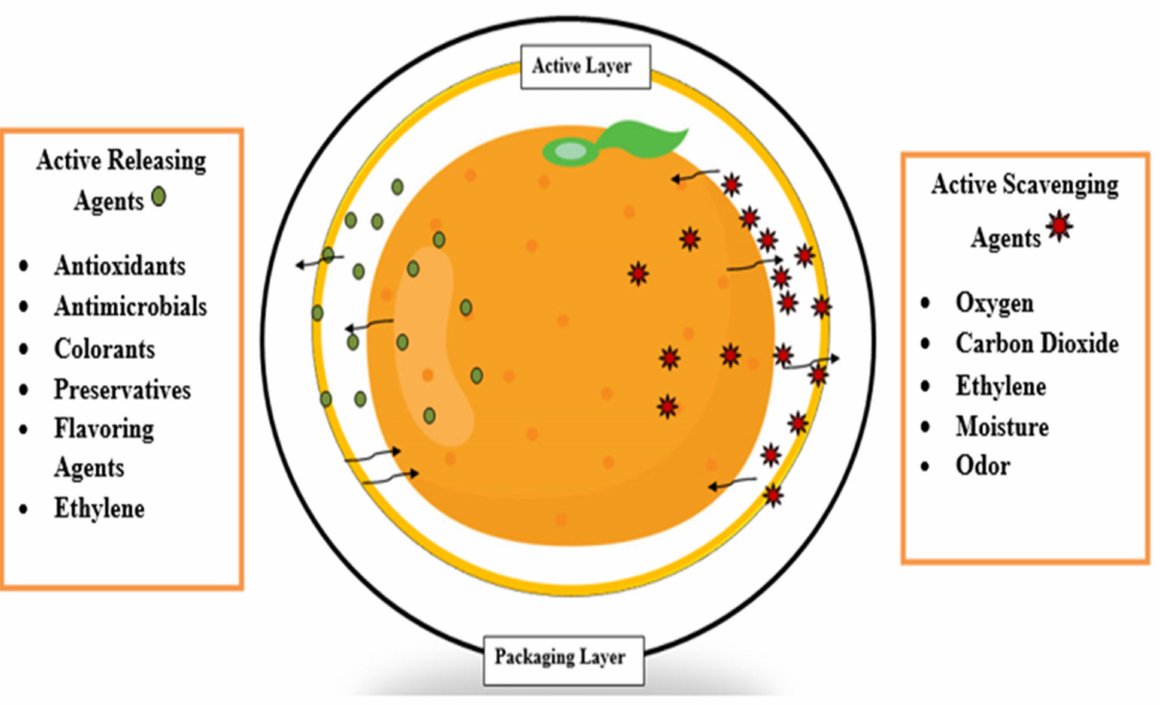
Figure 7. Mechanism of active packaging on a